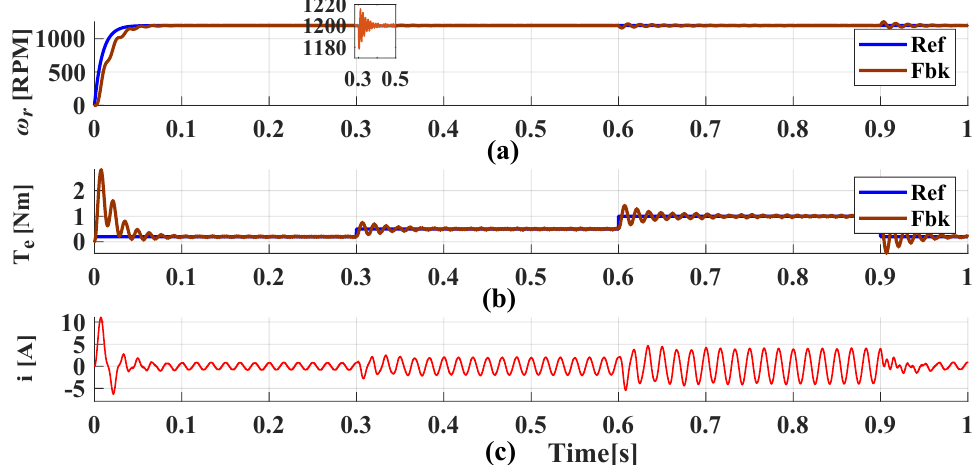
Figure 13. Simulation result of the 9-level inverter: ( a ) Speed reference and its feedback. ( b ) Torque reference and its feedback. ( c ) Phase